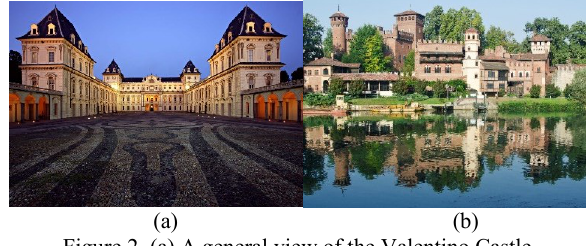
Figure 2. (a) A general view of the Valentino